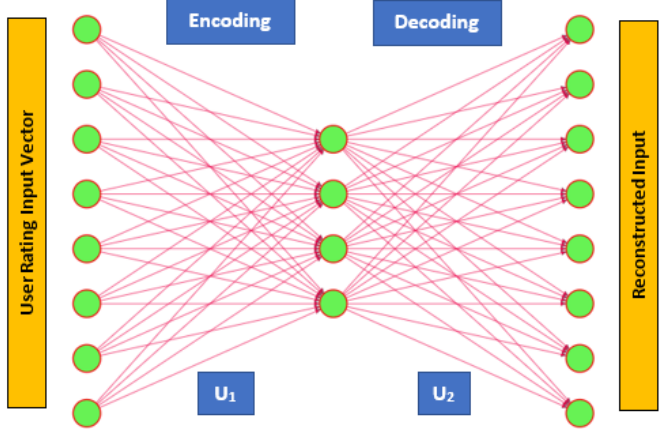
Figure 2. Multi ‐ neural architecture of a basic auto ‐ encoder for an RS . Figure 2. Multi-neural architecture of a basic auto-encoder for an